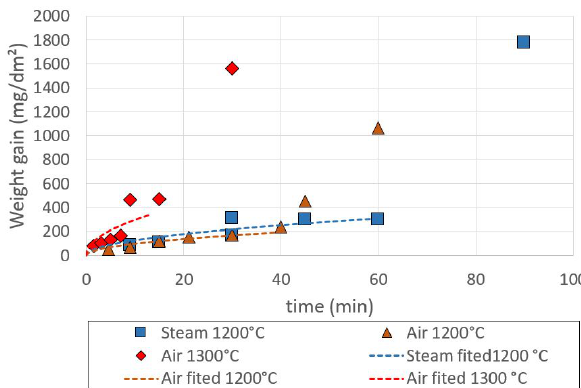
Figure 3. The results for oxidation with Cr-coated samples in steam at 1200 °C and air at 1200 and 1300 °C. The fits show parabolic pre-breakaway part of the kinetics. Delayed breakaway point for oxidation in steam is visible.